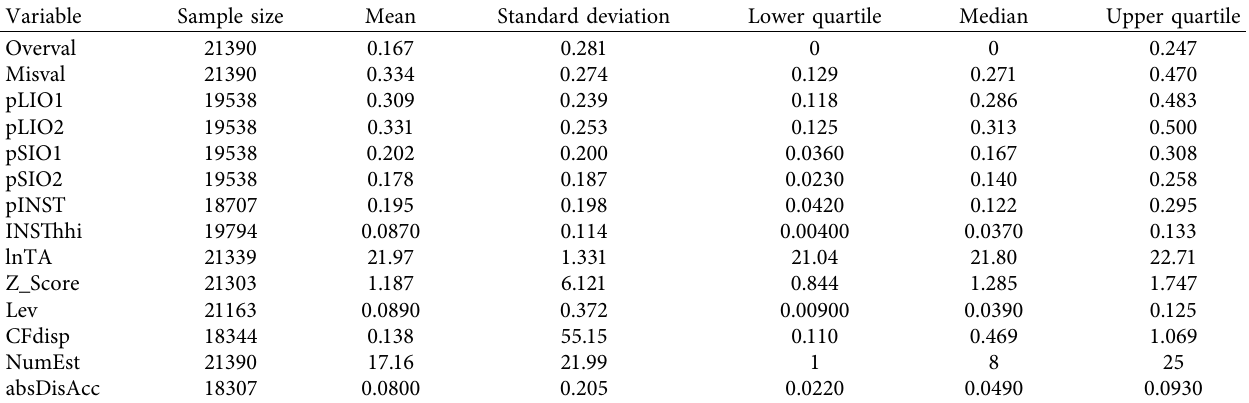
Table 1: Descriptive statistics.